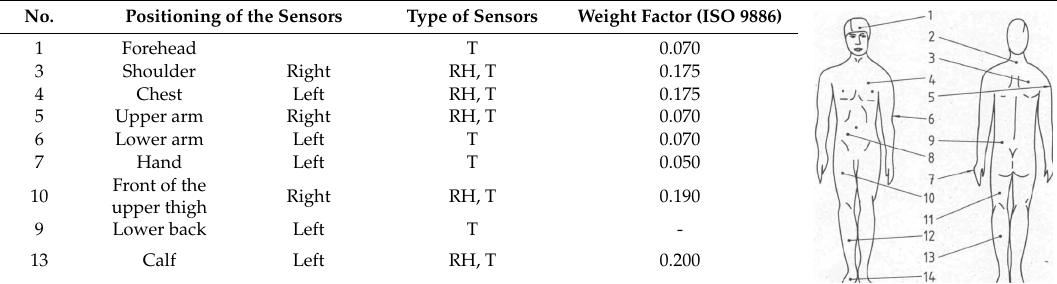
Figure 4. Development of a thermophysiological virtual model of the test person, ( a ) 3D virtual model of the test person, ( b ) Fiala Model [26], and ( c ) thermophysiological model of the test person.